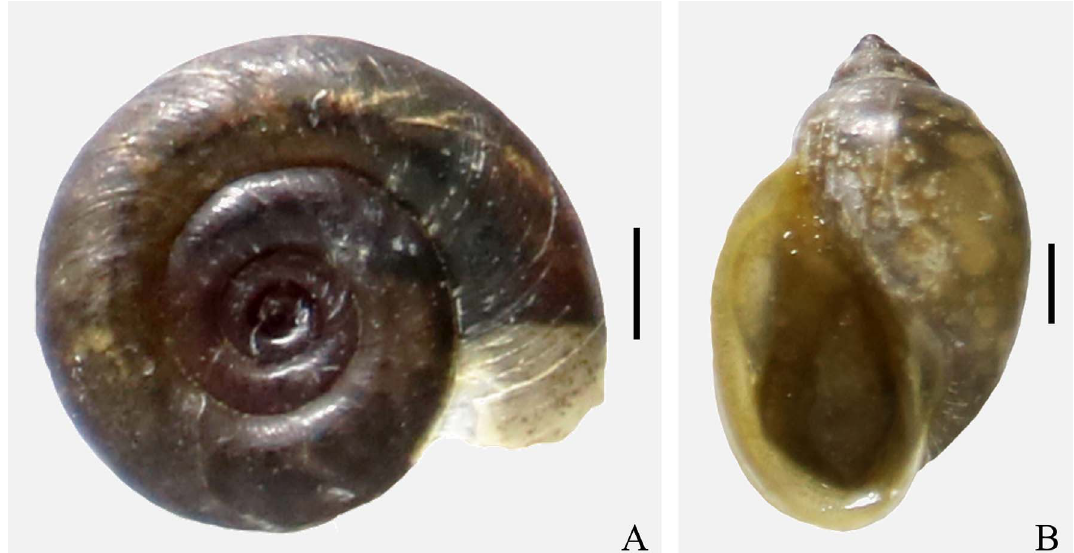
Figure 3. Two freshwater gastropods infected by Trichodina unionis . (A) Gyraulus siamensis , (B) Physella acuta . Scale bars: 1 mm.